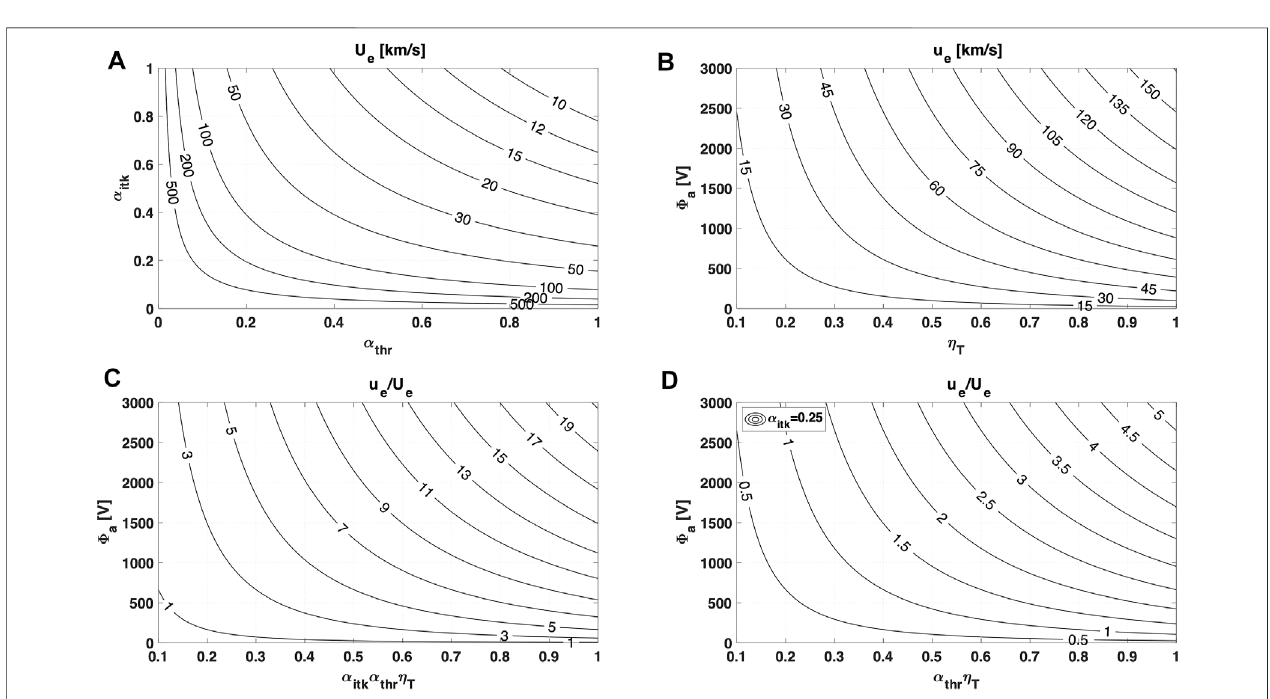
FIGURE 6 | (A) Minimum exhaust velocity U e required to provide a positive net thrust vs. intake and thruster transmission; (B) achievable exhaust velocity u e vs. accelerationvoltageand thrustef fi ciency,forareference21 amu propellant mass; (C) u e / U e vs. accelerationvoltage and overall propulsion system performance; (D) u e / U e vs. acceleration voltage and thruster performance, for a reference 25% intake